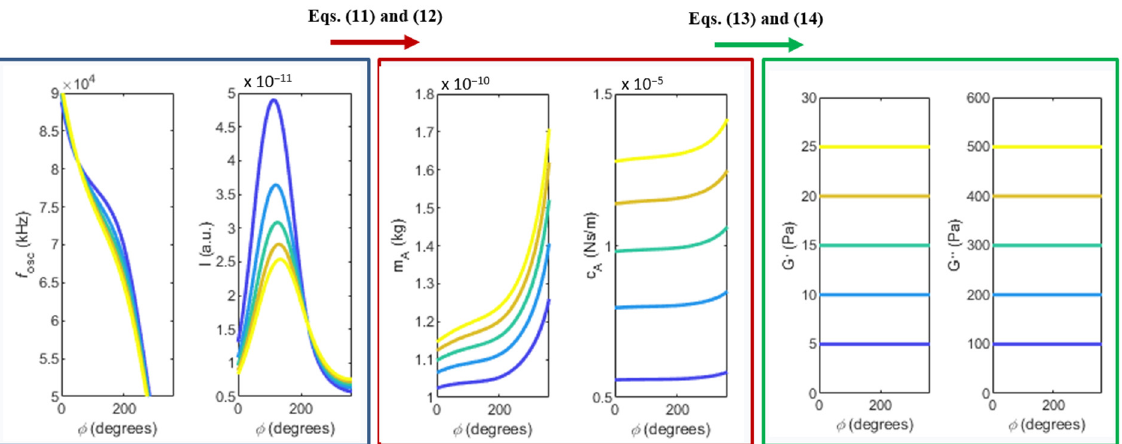
Figure 6. Inversion problem: the frequency and normalised amplitude should be experimentally measured, as indicated in the left panel (these curves were analytically built, instead). From these curves, the added mass and damping terms are calculated, as plotted in the middle panel. Finally, the viscous and elastic modulus of the fluid can be determined, as shown in the right